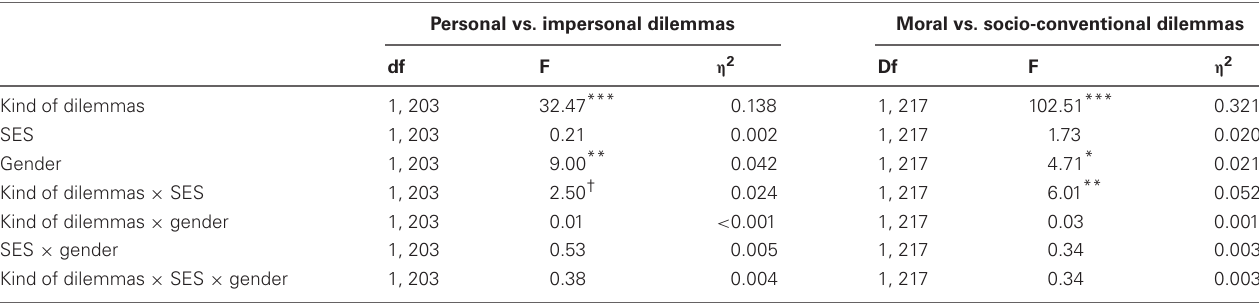
Table 7 | Summary of ANOVA for personal vs. impersonal and moral vs. socio-conventional dilemmas, including SES as fixed